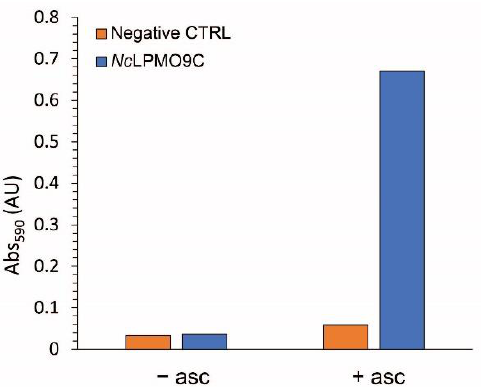
Figure 9. Azo-xyloglucan assay to measure LPMO activity. Nc LPMO9C activity with azo-xyloglucan in the presence or absence of ascorbic acid. Reactions were run at 55 ◦ C for 10 min in a final volume of 0.6 mL and contained 0.06 mg/mL enzyme, 1% ( w / v ) substrate, 2.5 mM ascorbic acid in a 100 mM sodium acetate buffer pH 4.5. Reactions were stopped by the addition of 1 mL of 96% ethanol. After centrifugation at 1000 × g for 10 min to separate the substrate, the released azo-labelled oligos were quantified by measuring absorbance at 590 nm.